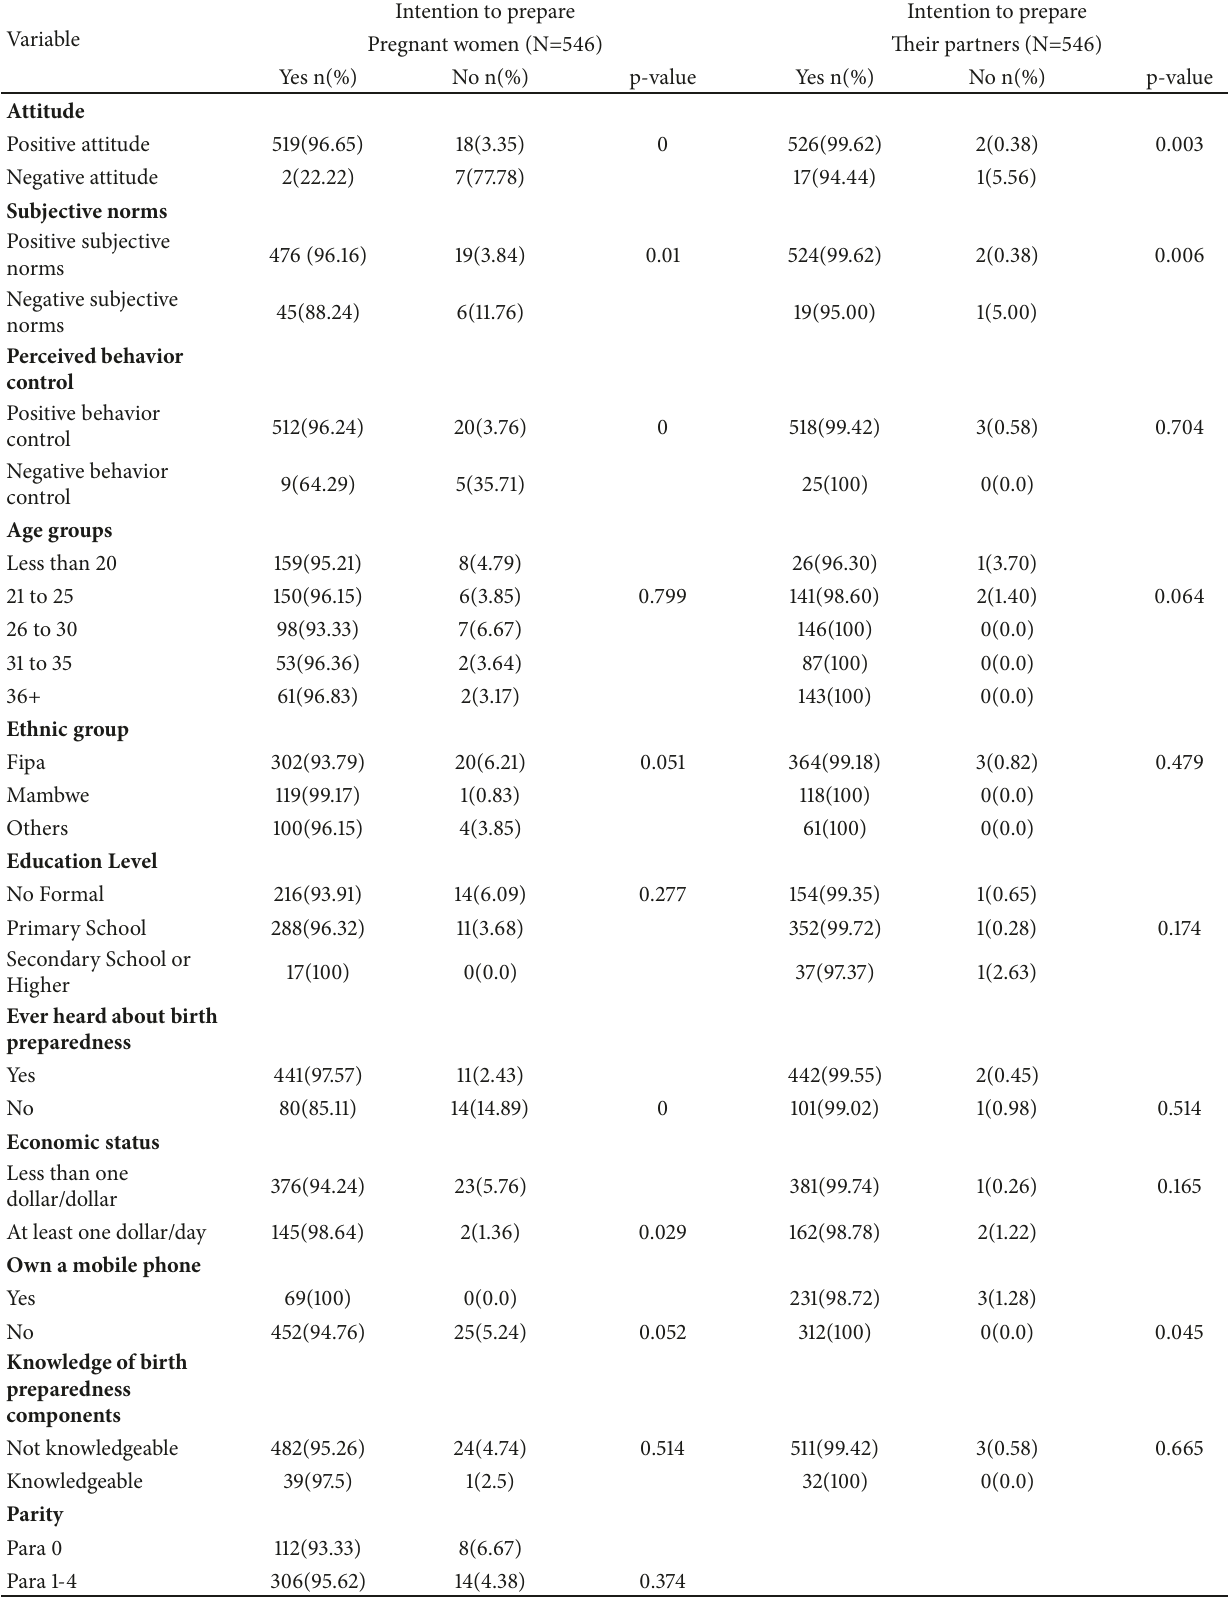
Table 3: Distribution of participants by birth preparedness intention and the potential factors affecting birth preparedness intention (Chi-